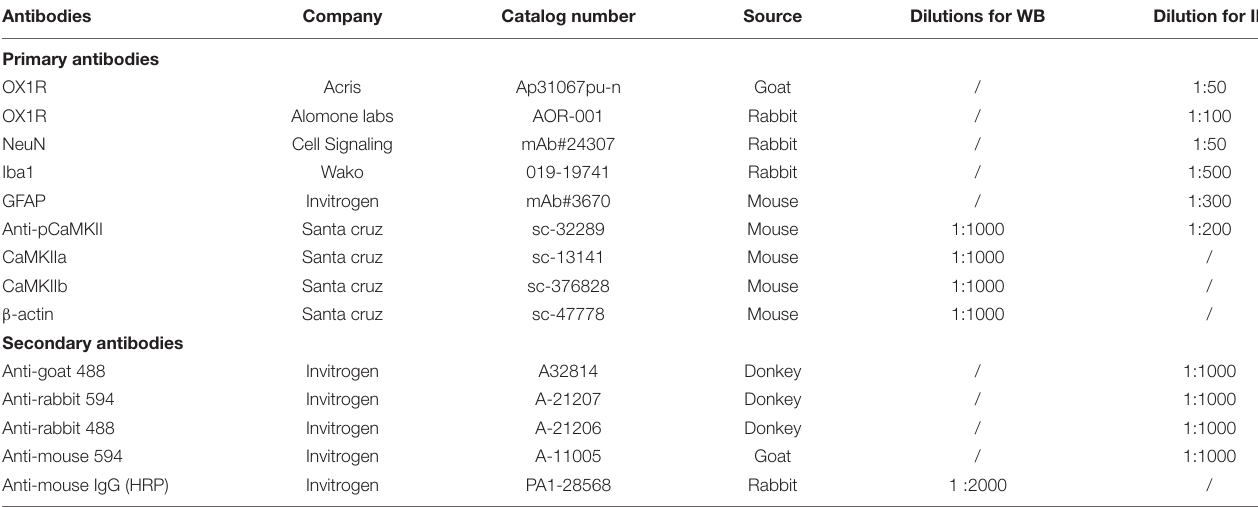
TABLE 1 | The information of the antibodies used in the study. Antibodies Company Catalog number Source Dilutions for WB Dilution for IF